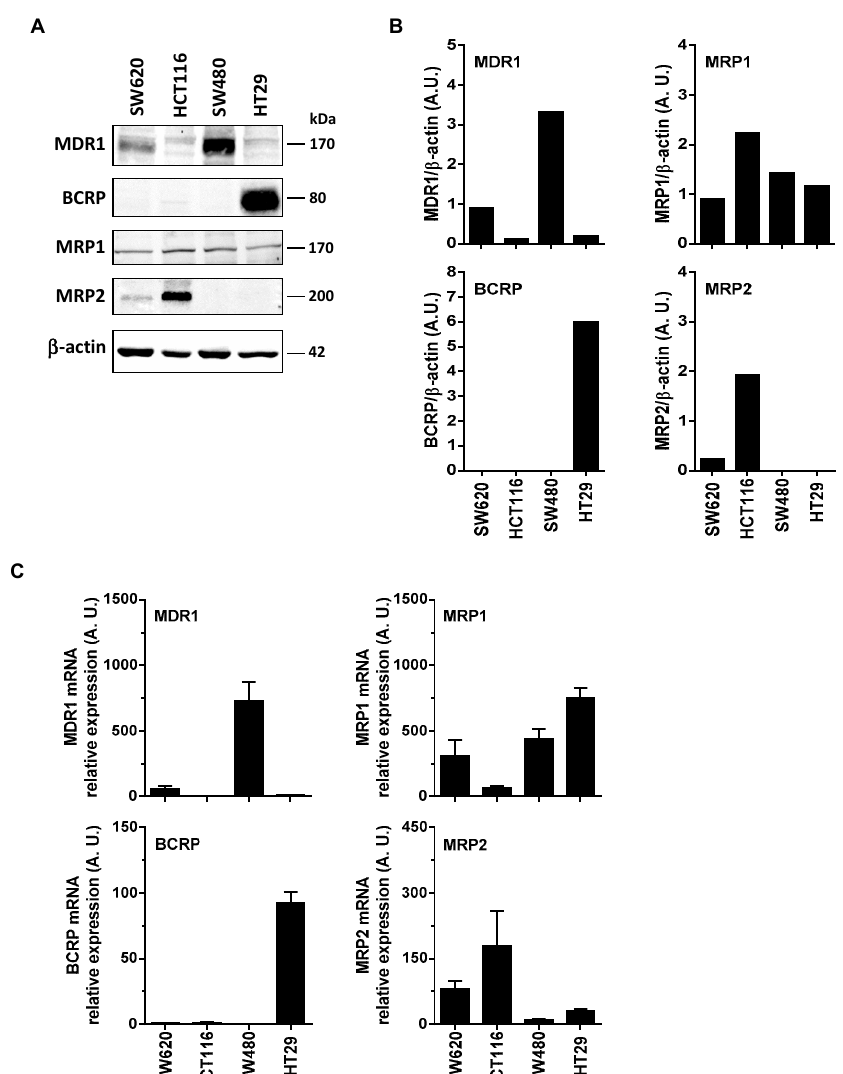
Figure 2. Differential expression of ABC transporters in human colorectal cancer cell lines. ( A ) Cells were seeded in T25 cm 2 flasks and cultured in complete media until confluency was reached and before protein extraction and western blot analysis with specific anti-ABC transporters primary antibodies. Representative immunoblots from three independent experiments are shown. β -actin was used as a loading control. ( B ) Densitometry quantification of representative blots. ( C ) In the same experimental conditions as in (A), total RNA were extracted from confluent cells and ABC transporters genes were analyzed by RT-qPCR. Histograms represent mean relative expression (A.U., arbitrary units) ± S.D. of three independent experiments each performed in triplicate per condition. The efflux of resveratrol is mediated by active mechanisms in human colon carcinoma cells. Table 1. Resveratrol efflux rates in colon cancer cell lines as a function of temperature Vi = % of resveratrol efflux . min -1 Tumor cell line